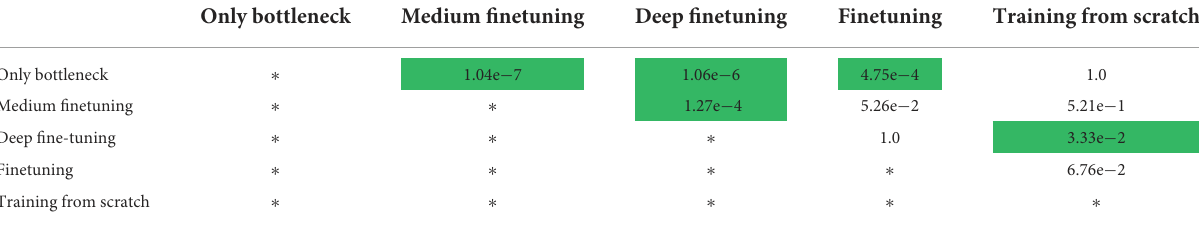
TABLE 6 Bonferroni-corrected p -values of independent t -tests for each pair of transfer learning strategies. Only bottleneck Medium finetuning Deep finetuning Finetuning Training from scratch